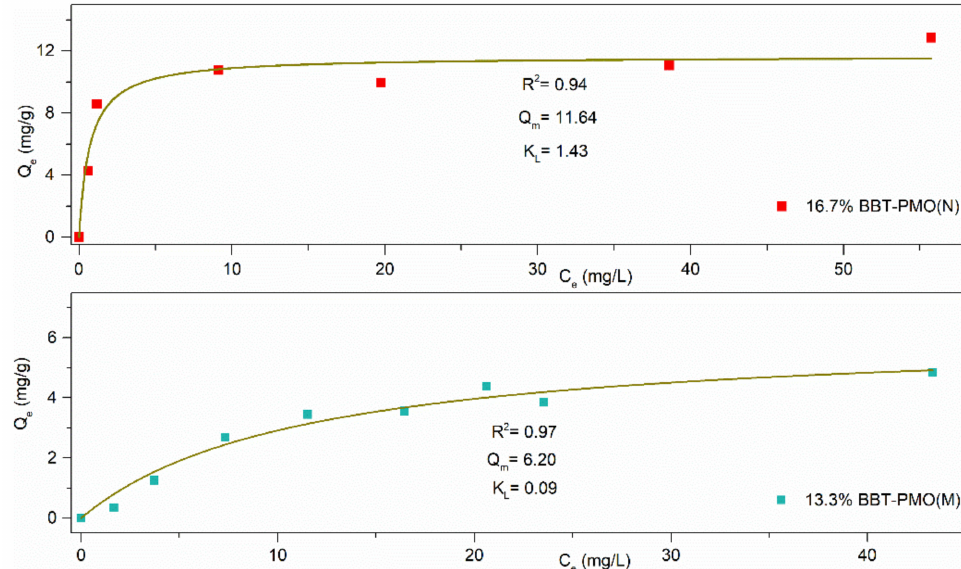
Figure 2. Adsorption kinetics of Cr(VI) for 16.7% BBT-PMO(N) (top) and 13.3% BBT-PMO(M) (bottom) at 298 K, pH = 2, inserted with the fitting kinetic